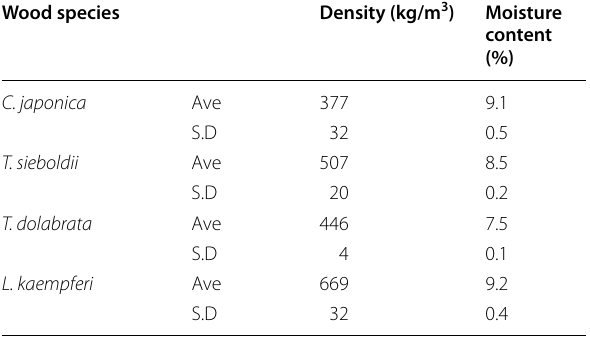
Table 1 Basic properties of tightening test